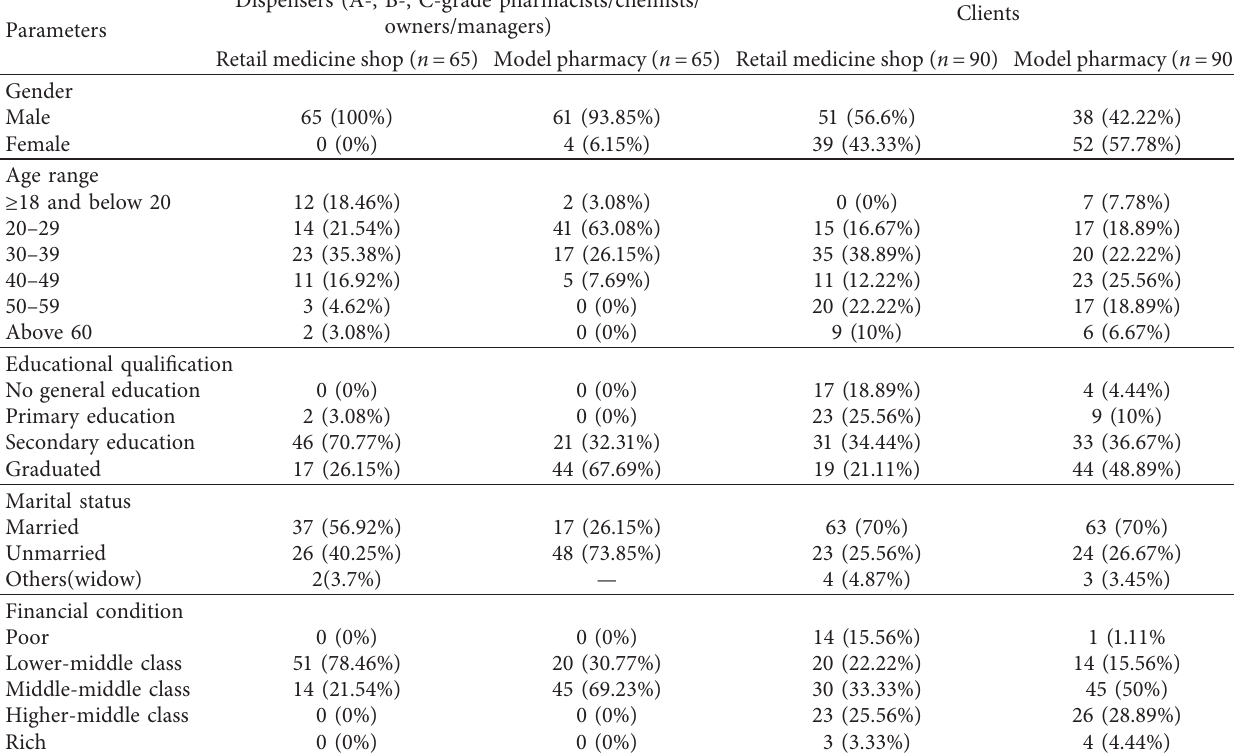
Table 7: Demographic data for model and local pharmacy for information collected from dispensers and clients obtained from PIM.